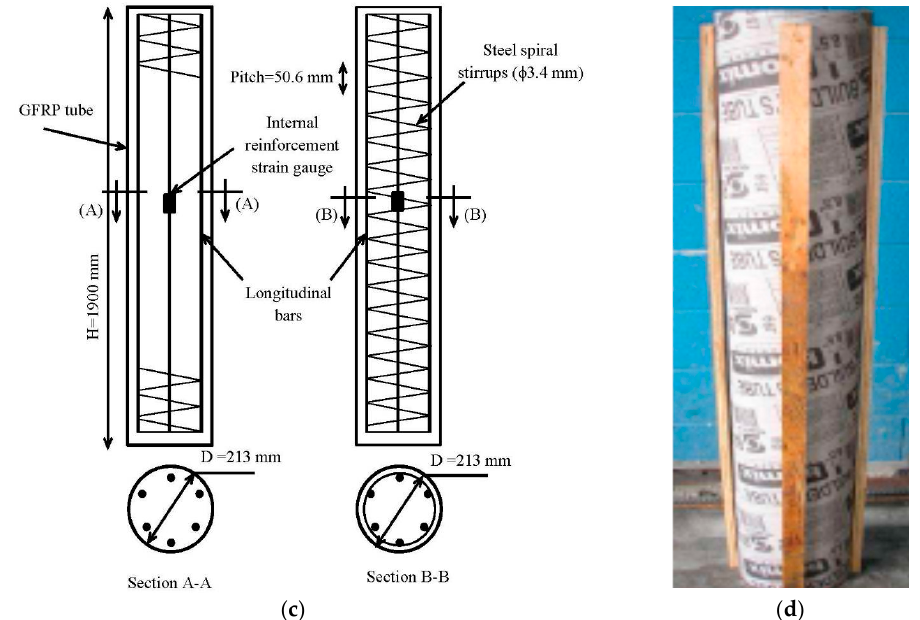
Figure 7. Instrumentations and test setup: ( a ) schematic of the test setup and placing of specimen instrumentations; ( b ) test specimen inside the testing machine; ( c ) test specimens details A-A for concrete-filled, fiber-reinforced polymer (FRP) tube (CFFT) and B-B for reinforced concrete (RC) columns; ( d ) cardboard construction of RC columns.